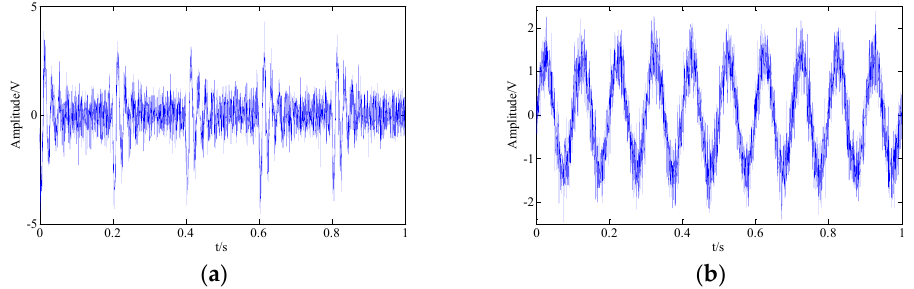
Figure 5. The Bayesian information criterion (BIC) value of composite original.